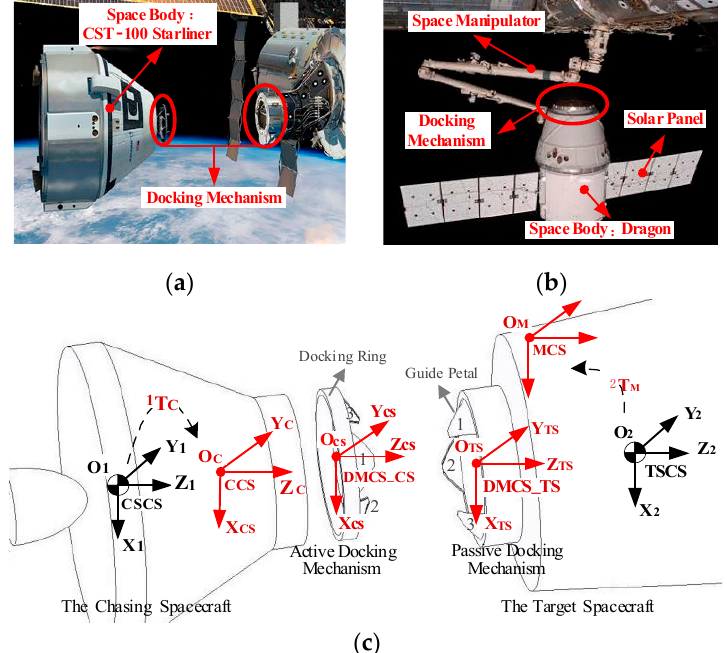
Figure 1. Coordinate systems defined in this paper. ( a ) CST-100 Starliner developed by Boeing (docking mechanisms are marked with red circles). ( b ) Dragon developed by SpaceX (docking mechanism is marked with a red circle). ( c ) Definitions of the coordinate systems. Table 1. Coordinate systems used for low impact docking (as shown in Figure 1).